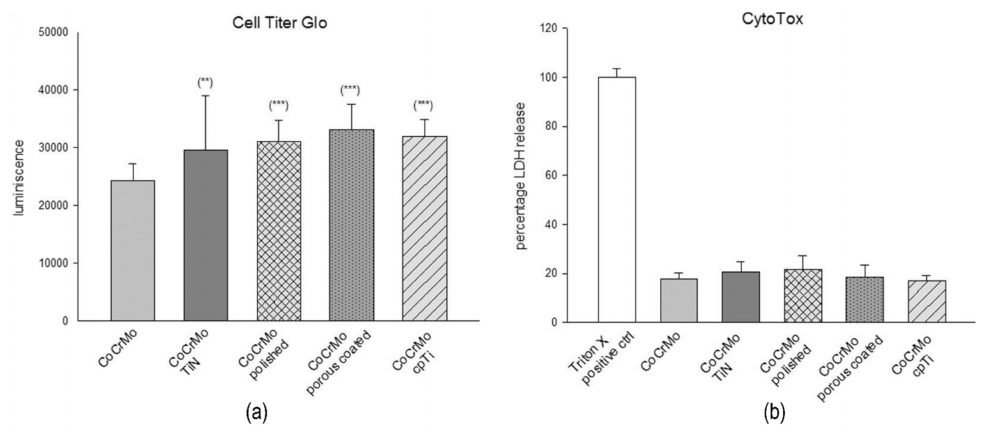
Figure 9. ( a ) Cell viability ( p < 0.01 **; p < 0.001 ***) ( b ) CytoTox LDH release. Adapted with permission from [142].